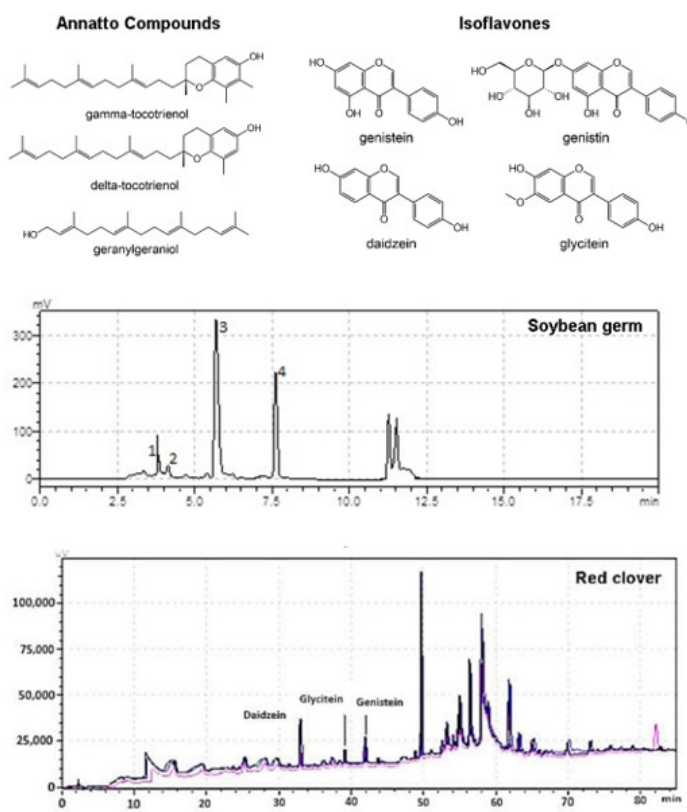
Figure 1. Top: compounds found in the used formulations. The first chromatogram show isoflavones identification from the soybean germ, which are the same added to Ormona ® SI; the peaks represent genistein (1), genistin (2), daidzein (3), glycitein (4). The second chromatogram shows the compounds from Ormona ® RC, where daidzein, glycitein, and genistin could be identified.